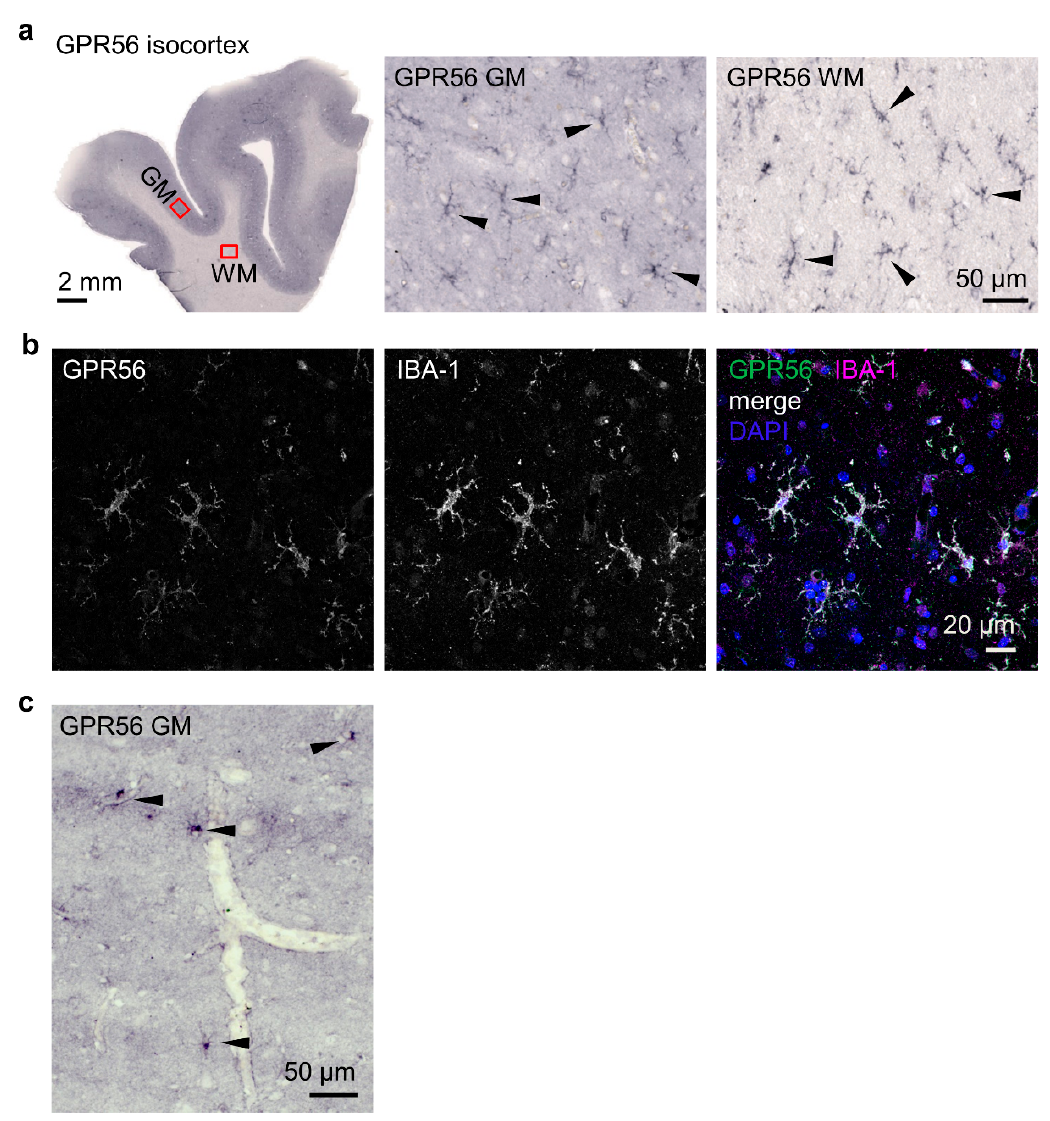
Figure 4. GPR56 is expressed in IBA-1-positive microglia. ( a – c ) Immunostained brain paraffin sections using the GPR56 NTF4 Ab. ( a ) Left: GPR56-immunoreaction in the temporal cortex (A22) grey (GM) and white matter (WM). Middle: GPR56- positive cells, probably microglia cells, in the GM in all layers. Right: GPR56-positive cells, likely microglial cells, in the WM. ( b ) Double immunofluorescence labeling of GPR56 and IBA-1 in the temporal cortex GM. Nuclei were stained with DAPI. All IBA-1-positive microglial cells were GPR56-positive. ( c ) GPR56-positive isolated cells, likely astroglia cells, in the temporal cortex GM.